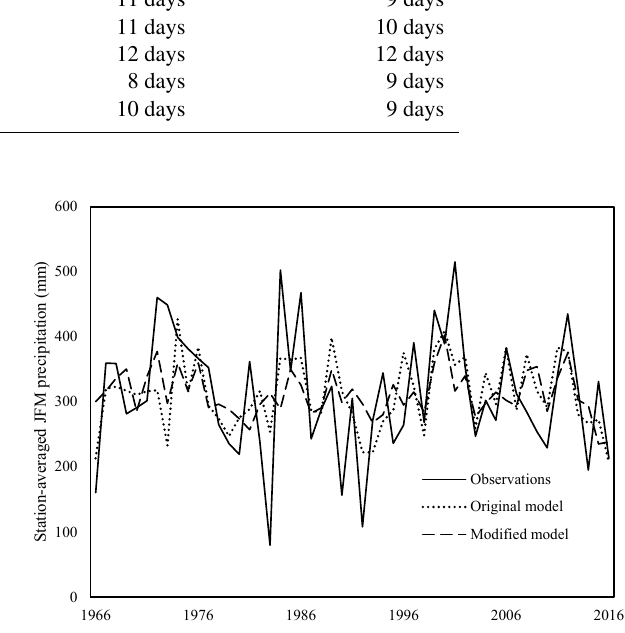
Figure 14. Observed conditions for the period of record, as well as hindcasts produced using the original model (11 potential predic- tors, 4 PCs) and the modified model (9 potential predictors, 3 PCs). Table 6. Hit–miss matrix for the modified model with three equal categories: above-normal (A), near-normal (N), and below-normal (B)